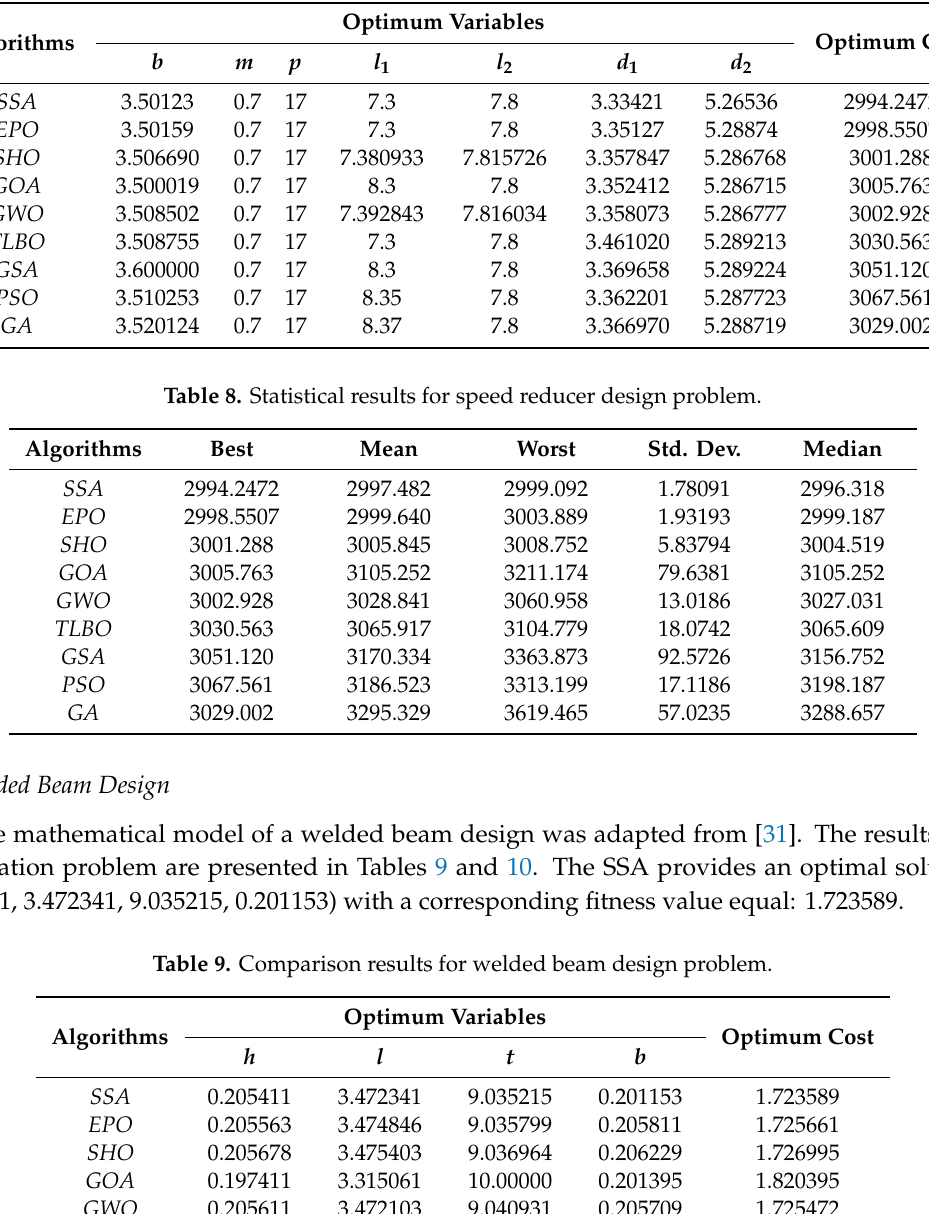
Table 7. Comparison results for speed reducer design problem.